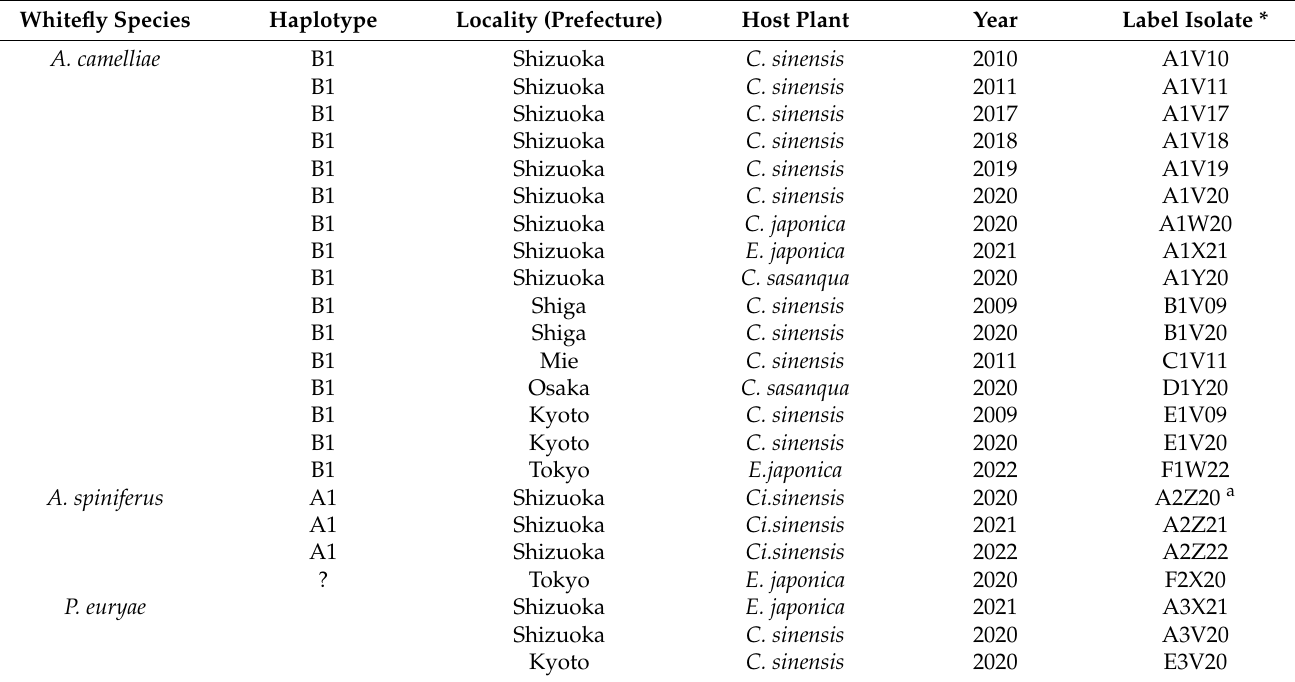
Table 1. Whitefly